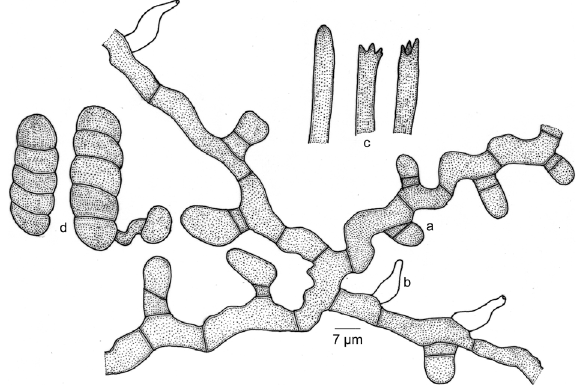
Figure 2. Meliola ailanthicola sp. nov. a - Appressorium; b - Phialide; c - Apical portion of the mycelial setae; d- Ascospores